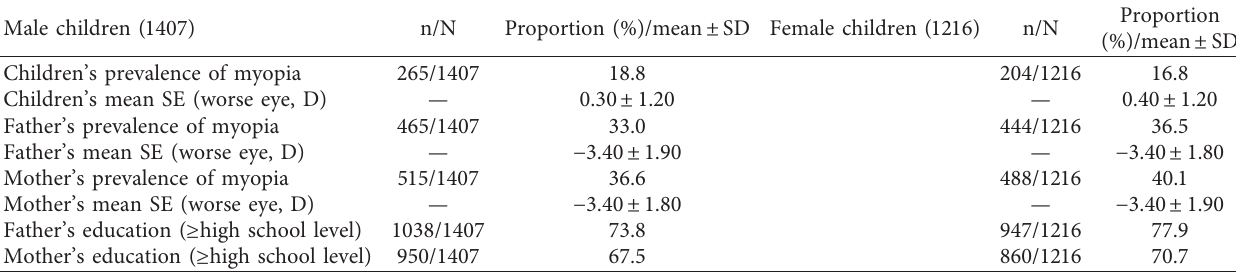
Table 1: Basic profile of children and their parents who received investigation.